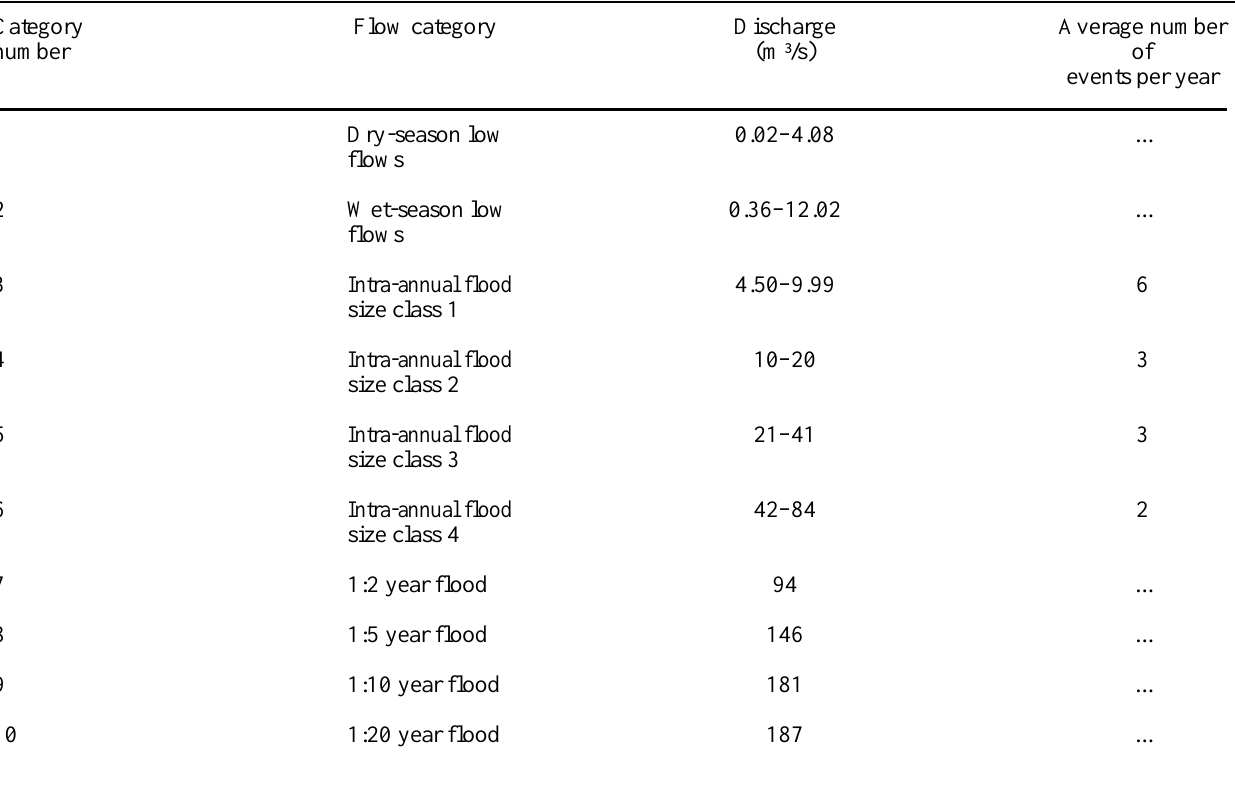
Table 1 . Summary statistics of the present near-natural flow regime at a study site in the Molenaars River, Western Cape, South Africa (Brown and King